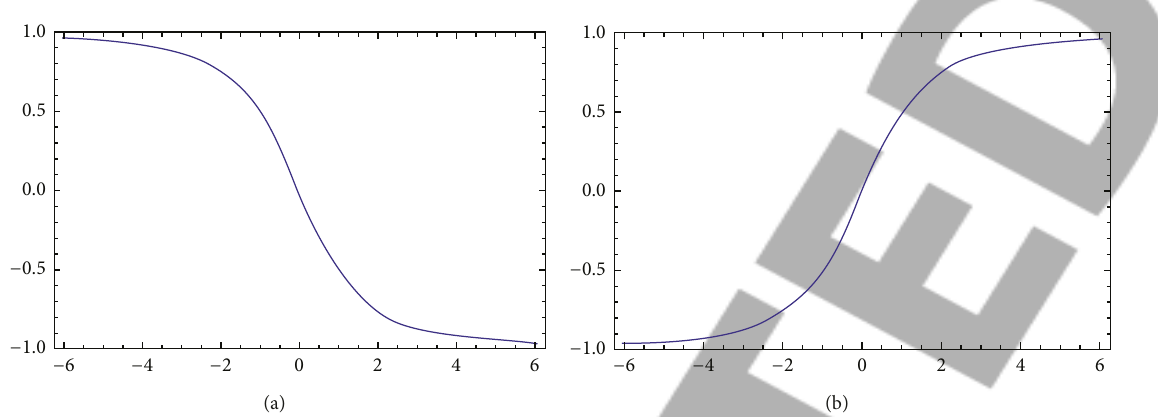
Figure 5: The simulation of the kink and antikink waves corresponding to the heteroclinic orbits of (7). (a)Antikink waves. (b) Kink waves.